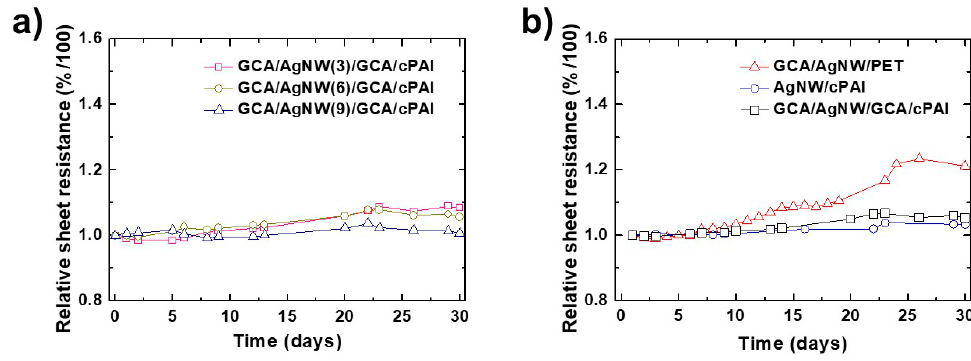
Figure 8. Sheet resistance stability test ( a ) based on the number of AgNW injections, ( b ) GCA/AgNW/PET, AgNW/cPAI, and GCA/AgNW/GCA/cPAI electrodes.